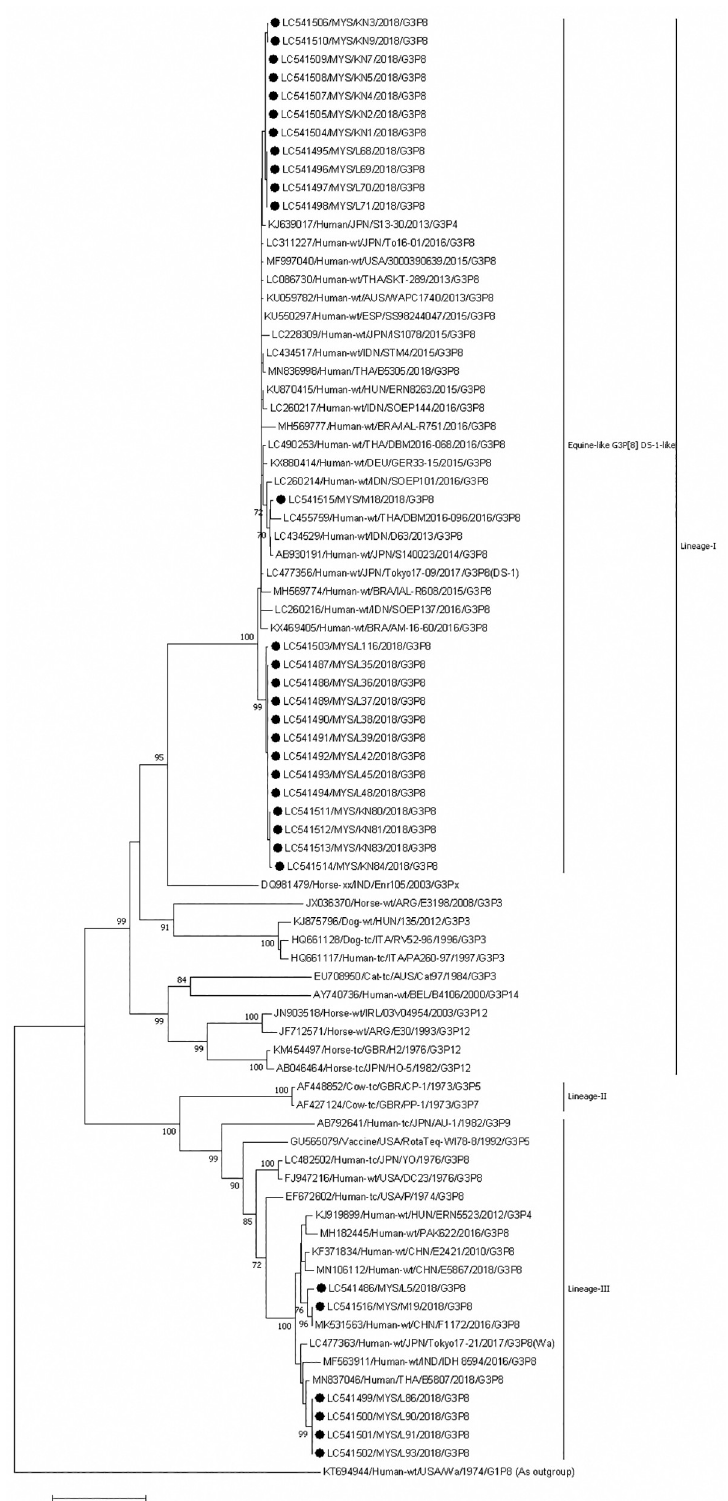
Fig 6. Phylogenetic tree constructed with the nucleotide sequences of the VP7 gene of G3 strains. Human rotavirus Wa-40-AG (G1) was used as an outgroup. The number adjacent to the node represents the bootstrap value and